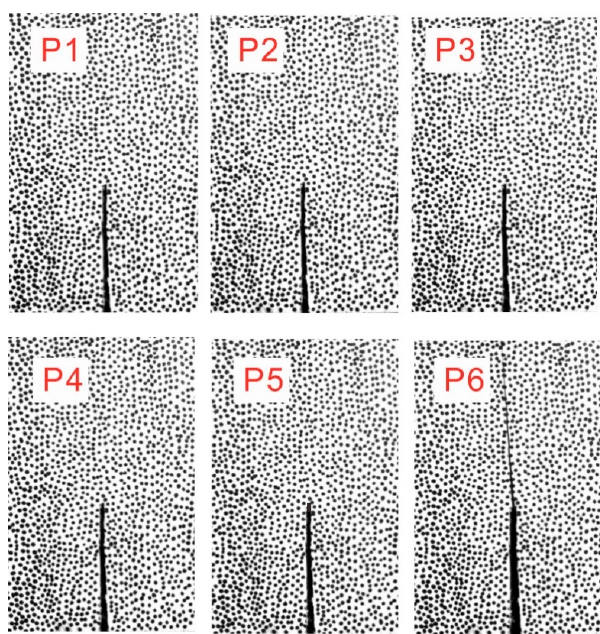
ff erent loading